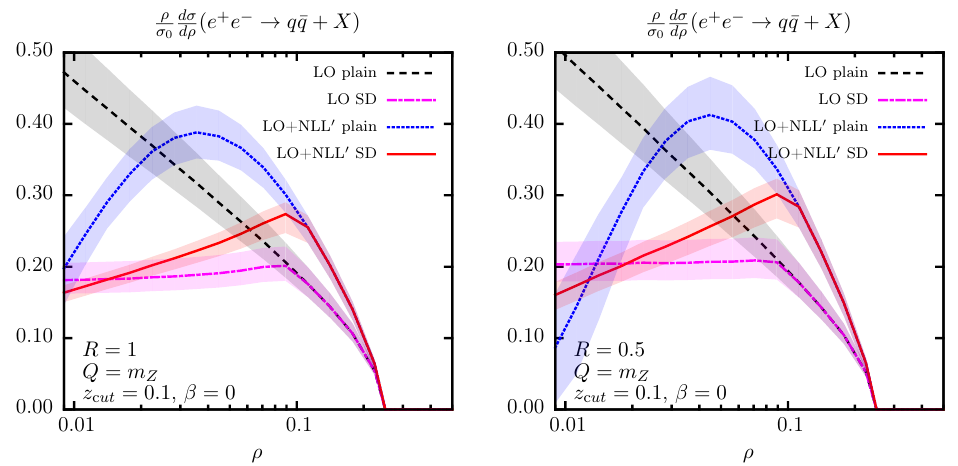
Figure 11 . The results for the (cid:12)xed order and resummed di(cid:11)erential cross section of the plain and soft-dropped jet mass with R = 1 (left) and R = 0 : 5 (right) for e + e (cid:0) collisions at a centre of mass energy Q = m Z and the soft drop parameters z cut = 0 : 1 and (cid:12) = 0. The (cid:12)gure shows LO for plain (cid:26) (black dashed) and soft-dropped (cid:26) (magenta dashed-dotted) and the matched LO+NLL 0 cross section for plain (cid:26) (blue dotted) and soft-dropped (cid:26) (red solid) with the bands from resummation and scale uncertainties